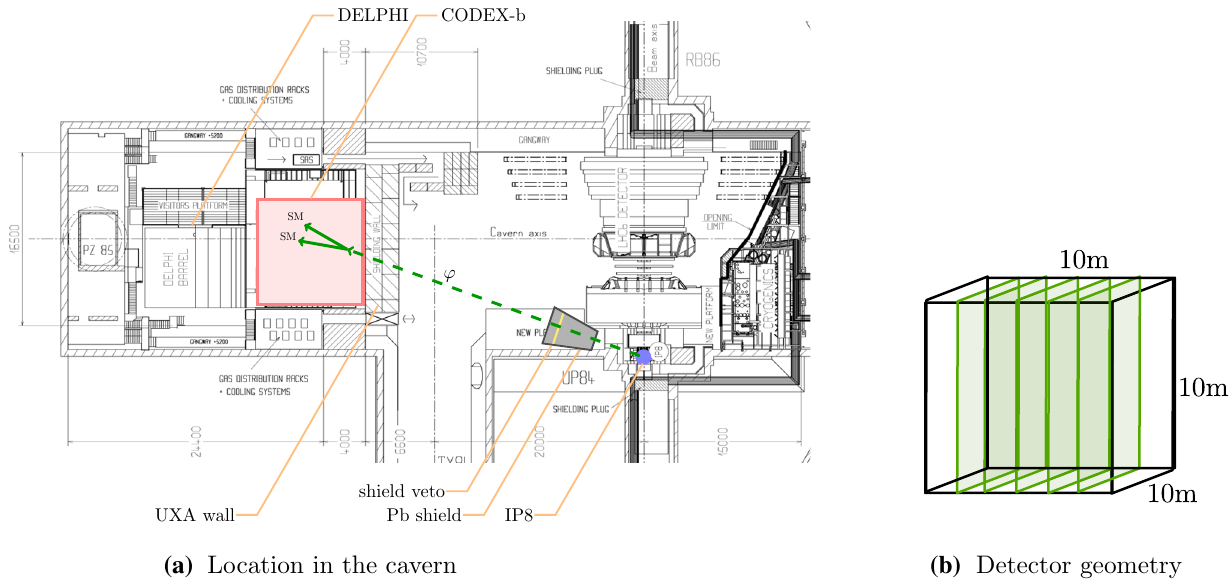
Fig. 3 Left: Layout of the LHCb experimental cavern UX85 at point 8 of the LHC [9], overlaid with the CODEX-b volume, as reproduced from Ref. [8]. Right: Schematic representation of the proposed detector